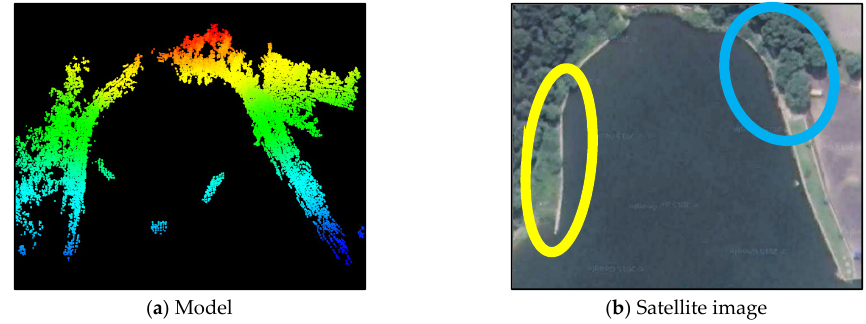
Figure 4. Experimental site (middle) and its 3D models: ( a ) 3D model obtained from USV; ( b ) satellite imagery of the experimental site, the green circled area is the slender bank and the blue circled area is the triangular area.